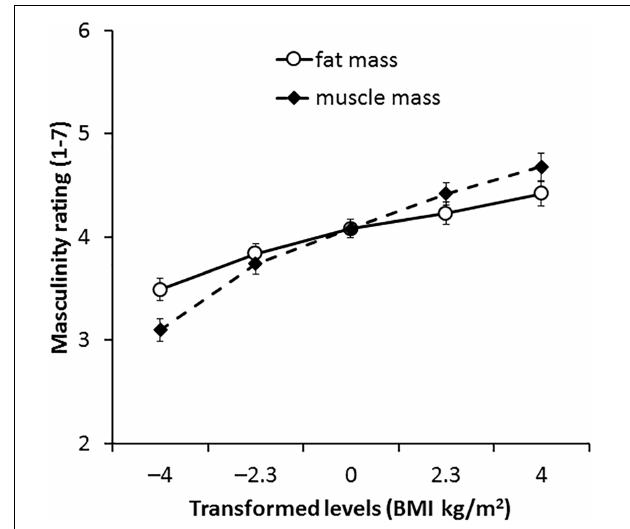
FIGURE 4 | Average masculinity ratings for faces transformed with the face shape correlates of fat and muscle mass for the 3D face set. Error bars represent the standard errors.